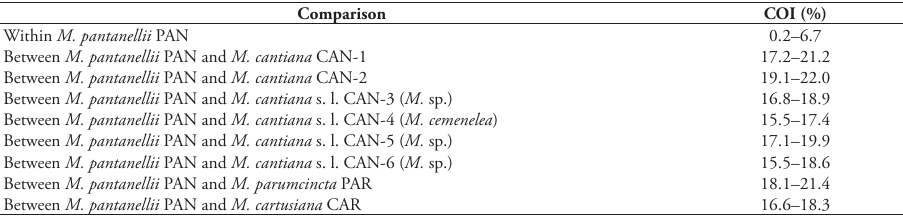
Table 5. Ranges of K2P genetic distances between analysed COI